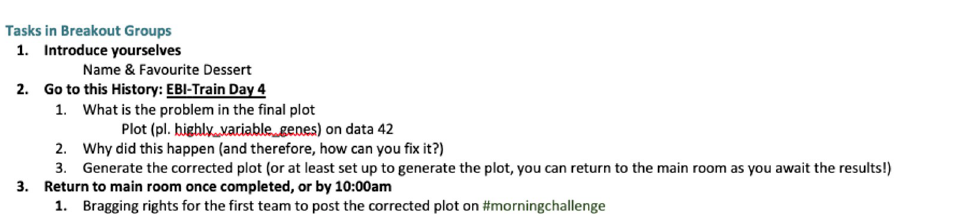
Fig 3. Example of a morning challenge instruction